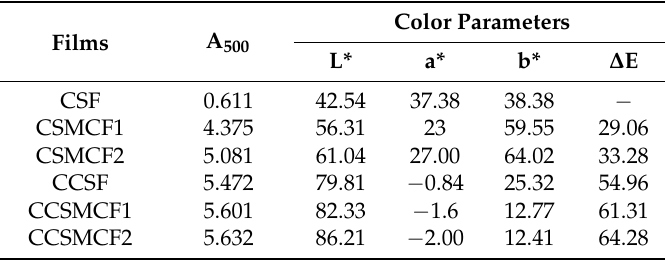
Table 3. The absorbance and color parameters of the developed